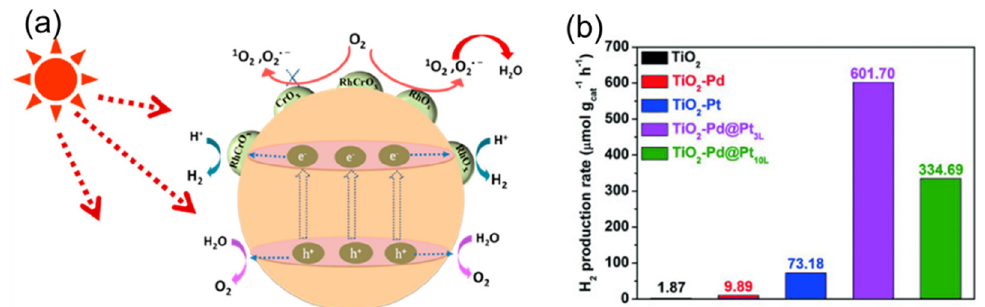
Figure 4. ( a ) Diagram of the mechanism by which RhCrO x promotes photocatalytic performance: RhO x could facilitate both the desired hydrogen evolution reaction (HER) and undesired reactions of superoxide radicals and singlet oxygen formation. On the contrary, CrO x inhibits formation of these two ROS although it could not promote the POWS reaction. Reproduced with permission from Ref. [90]. Copyright 2022, American Chemistry Society. ( b ) Photocatalytic H 2 evolution from water with the samples as catalysts under the same irradiation conditions. Reproduced with permission from Ref. [92]. Copyright 2022, Wiley.